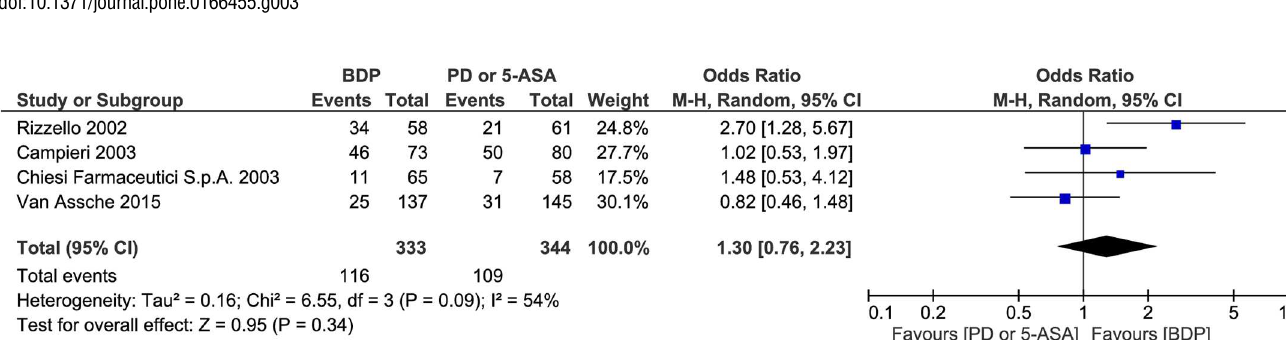
Fig 4. Forest plot of randomized controlled trials of oral BDP vs. oral PD or 5-ASA in inducing clinical remission in ulcerative colitis. BDP, beclomethasone dipropionate. PD, prednisone.5-ASA, mesalazine. M-H, Mantel-Haenszel.